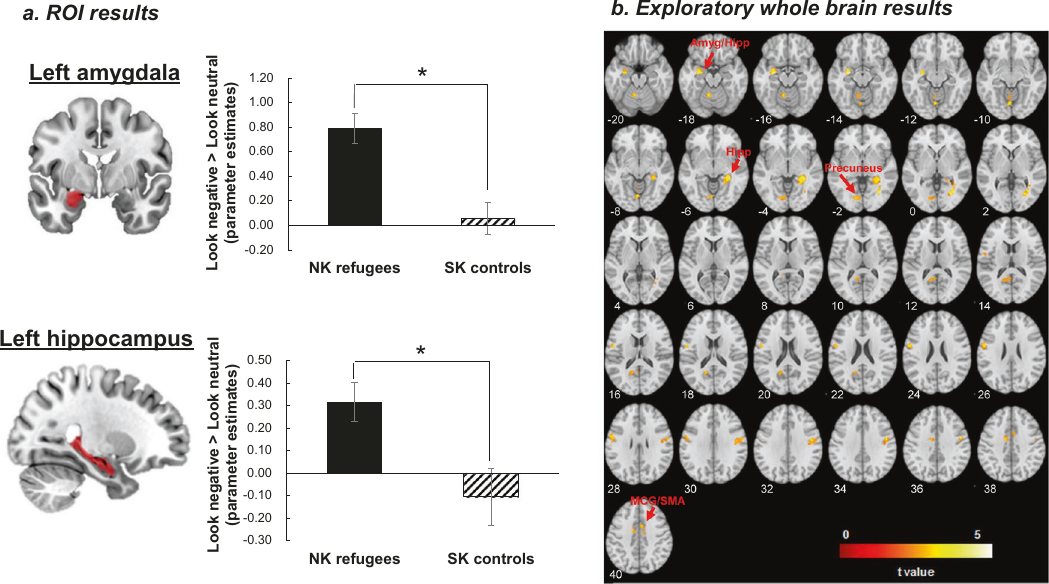
Fig. 1 Neural correlates of emotional reactivity. a Neural activation in response to negative socio-affective pictures (vs. neutral pictures) in the anatomically de fi ned amygdala and hippocampus ROIs between NK refugees and SK controls (* p < 0.05), b Results from the exploratory whole-brain analysis showing signi fi cant group differences in neural activation in response to negative socio-affective pictures (vs. neutral pictures) between NK refugees and SK controls (cluster-de fi ning threshold, p < 0.001; cluster size >80 voxels to achieve a cluster-wise corrected p < 0.05). ROI region of interest, NK North Korean, SK South Korean, Amyg/Hipp amygdala extending to hippocampus, Hipp hippocampus, MCG middle cingulate gyrus, SMA supplementary motor area.